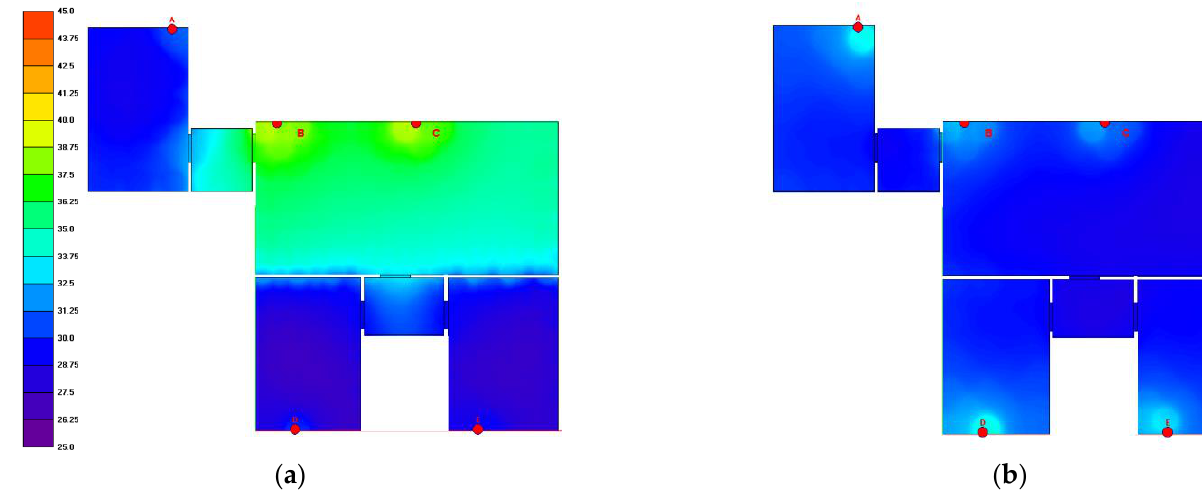
Figure 20. Four-room apartment. ( a ) “Night” configuration A-weighted sound pressure levels. ( b ) “Day” configuration A-weighted sound pressure levels. Table 11. Four-room apartment. Night and day configurations (in blue 0.5 1/h single CMV speed).